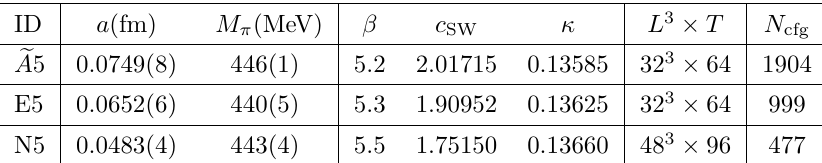
Table 1 . Parameters for the lattices generated by the CLS collaboration using two flavors of O ( a ) improved Wilson fermions. More details about these ensembles can be found in